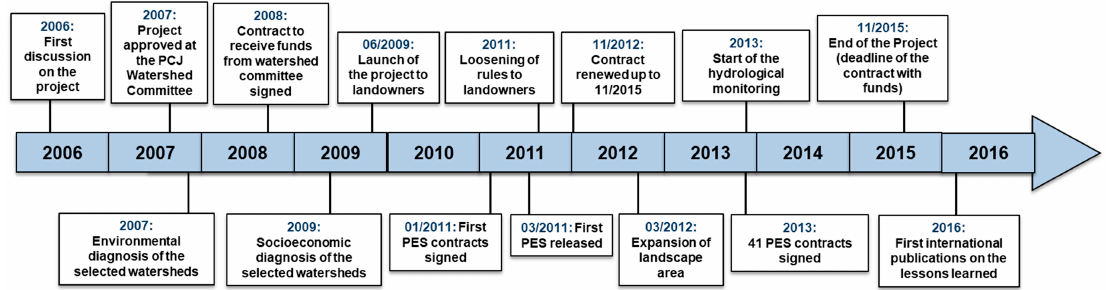
Figure 3. Timeline of the Water Producer Project, in the Piracicaba, Capivari, and Jundiai watershed, Atlantic Forest, Brazil. Modified from [24] (p. 17).